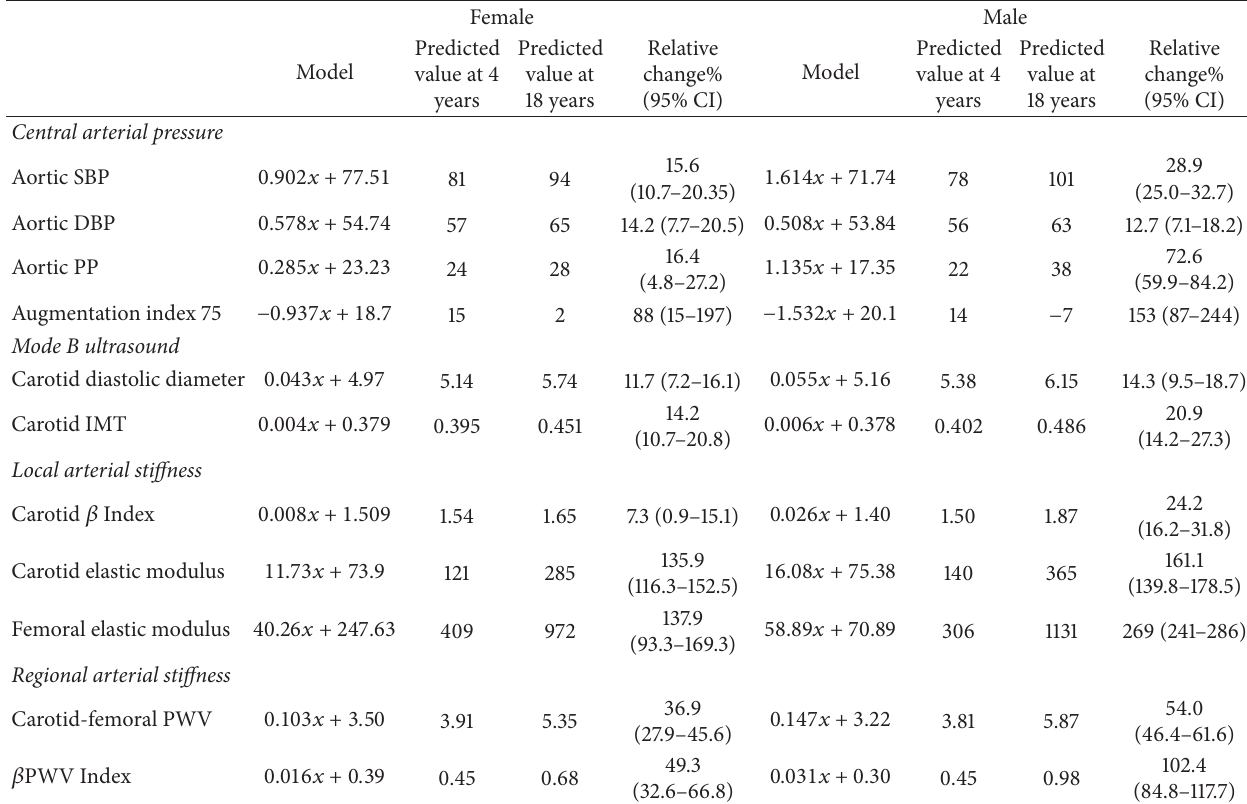
Table 3: Relative change (%) predicted in arterial parameters from 4 to 18